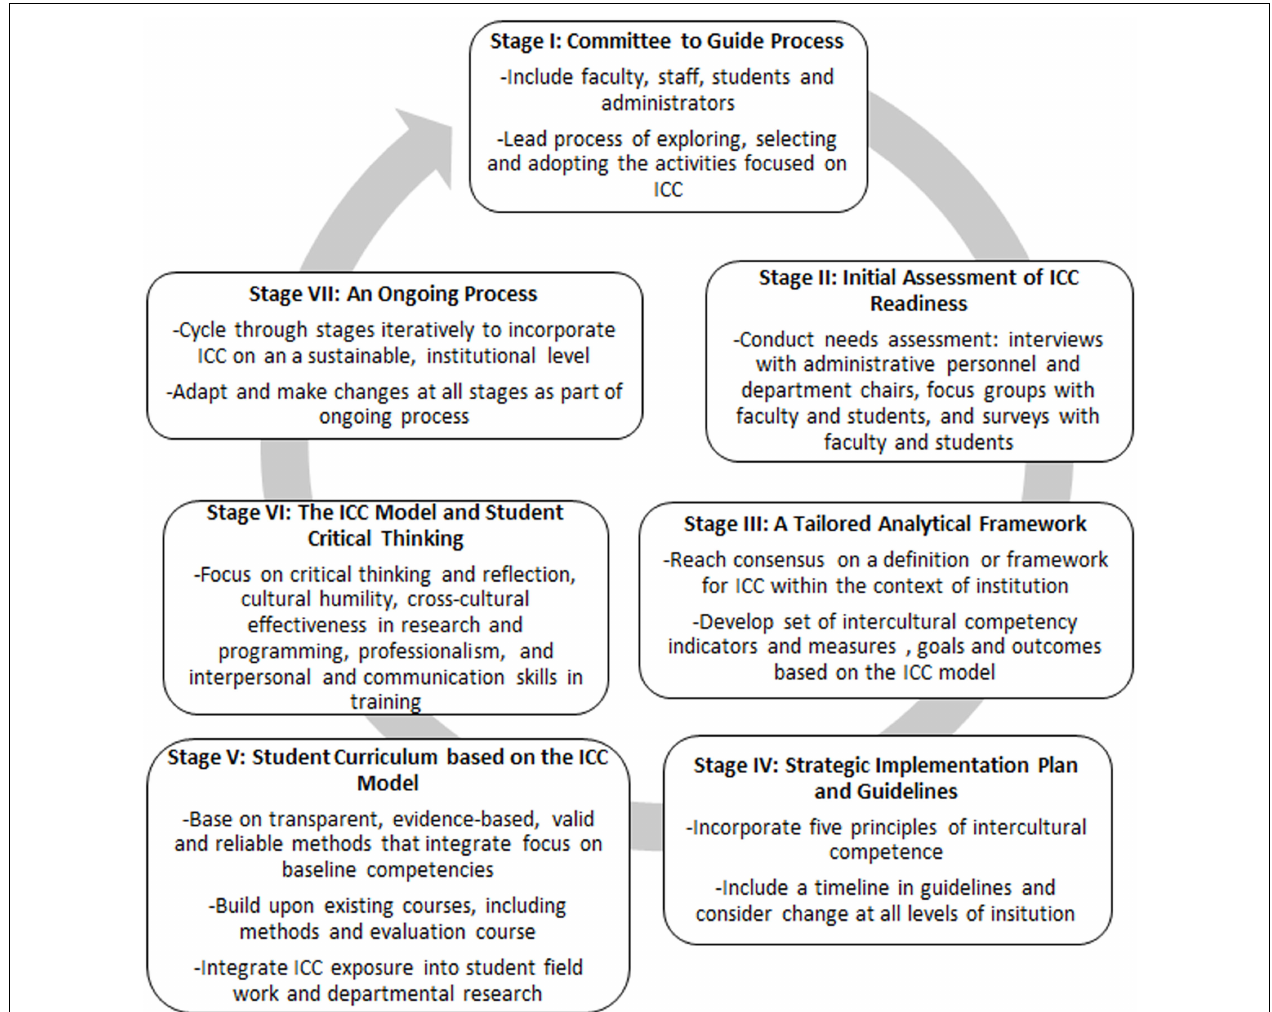
FIGURE 1 | Overview of intercultural competence (ICC) framework for Public Health Institutions